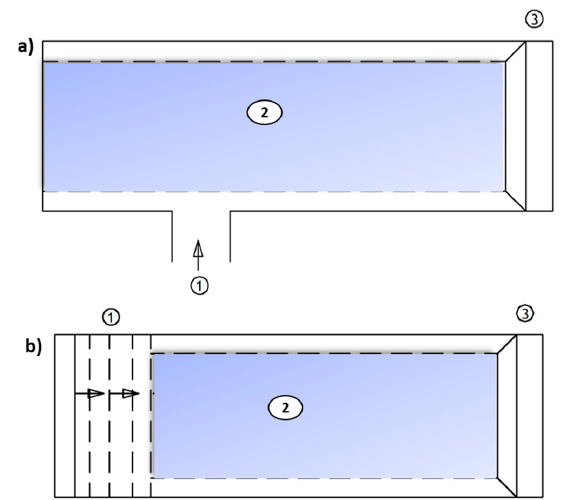
Figure 3. General layout of slide impact into a reservoir: 1 is the slide impact zone, 2 is the wave propagation zone and 3 the wave run-up and dam overtopping zone for ( a ) slide impacting from the side of a gorge; ( b ) solitary wave generated moving directly towards the dam’s upstream face.